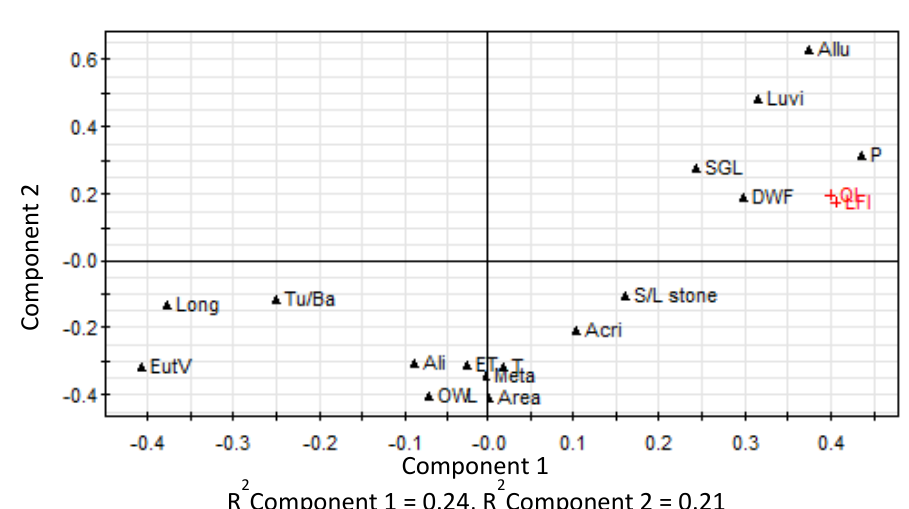
2 Component 2 = 0.27